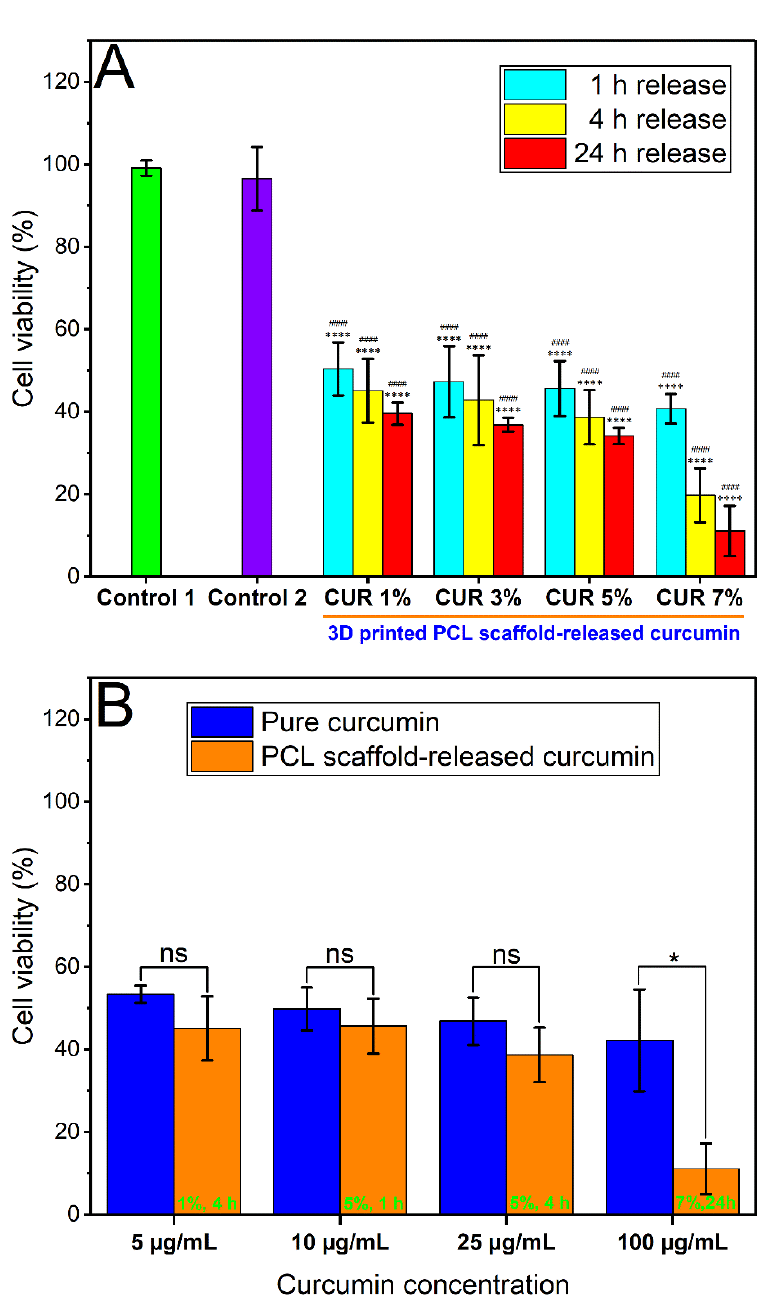
Figure 14. ( a ) Cytotoxic effects of curcumin in release media acquired in different durations (1 h, 4 h, 24 h) from 3D printed scaffolds with different loadings (1%, 3%, 5%, 7%, w / w ). ( b ) Comparison of cytotoxic effects of different concentrations of curcumin released from different loadings and release durations of PCL scaffold, with the respective curcumin concentrations (positive control) on the U87 cell line after 48 h treatment. Results from at least three replicate measurements are presented as mean ± SD. P-values were obtained via one-way analysis of variance (ANOVA). ns p > 0.05, * p ≤ 0.05. **** p < 0.0001 and #### p < 0.0001 compared to the untreated group (control 1) and